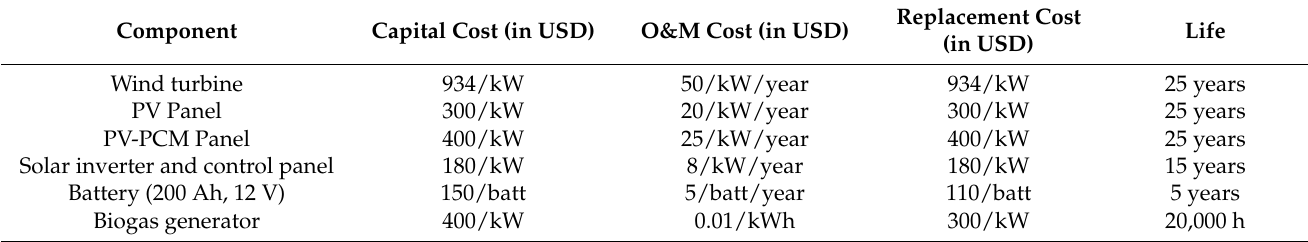
Table 6. Cost of various components of